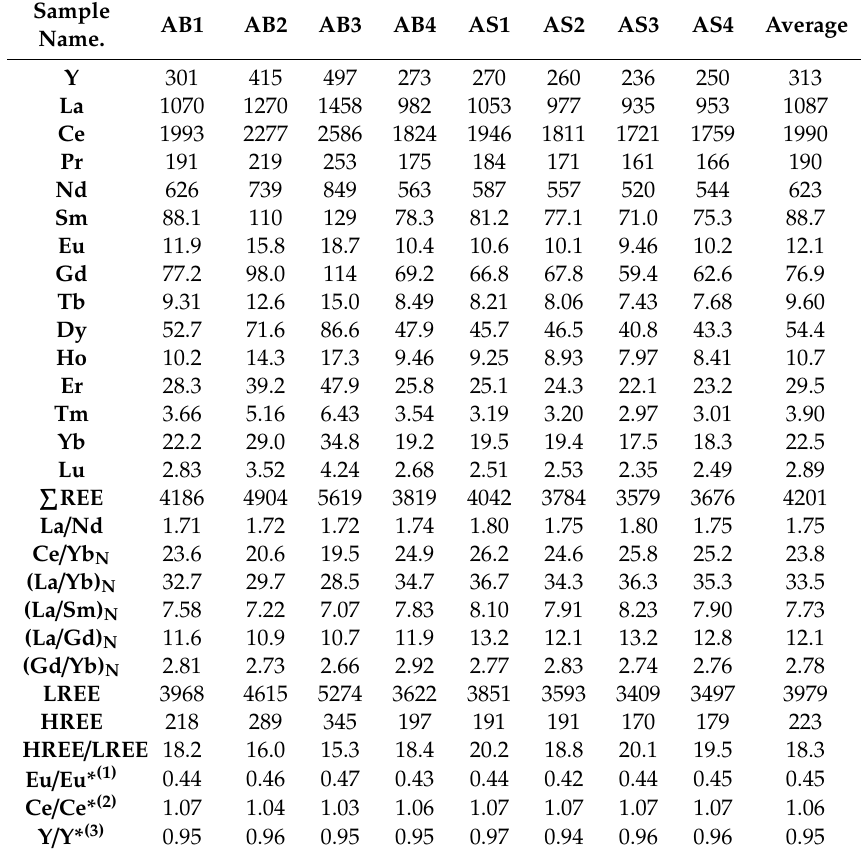
Table 1. REE abundances of apatite crystals in the Ghareh Bagh mica deposit (in ppm). Sample